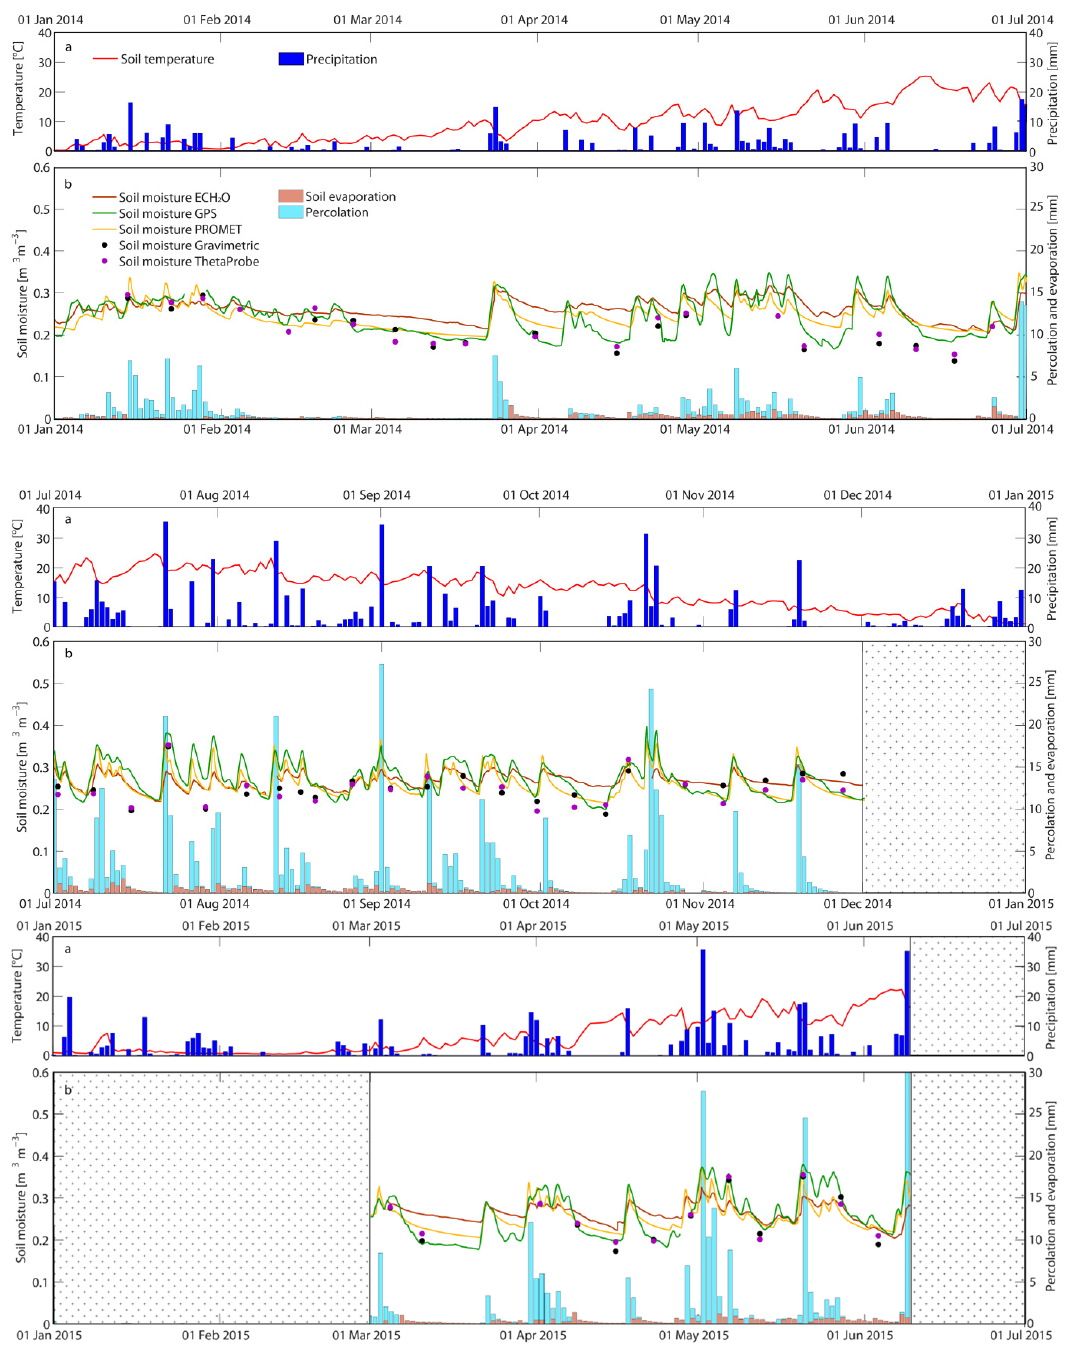
Figure 4. ( a ) Soil temperature at a soil depth of 5 cm and precipitation measured at the DWD test site in Munich as well as ( b ) soil moisture measured by GPS, ECH 2 O, ThetaProbe and gravitationally as well as modelled with PROMET at the DWD test site in Munich during the measurement period 1 January 2014–10 June 2015. The winter time with potential snow cover and soil frost is excluded.